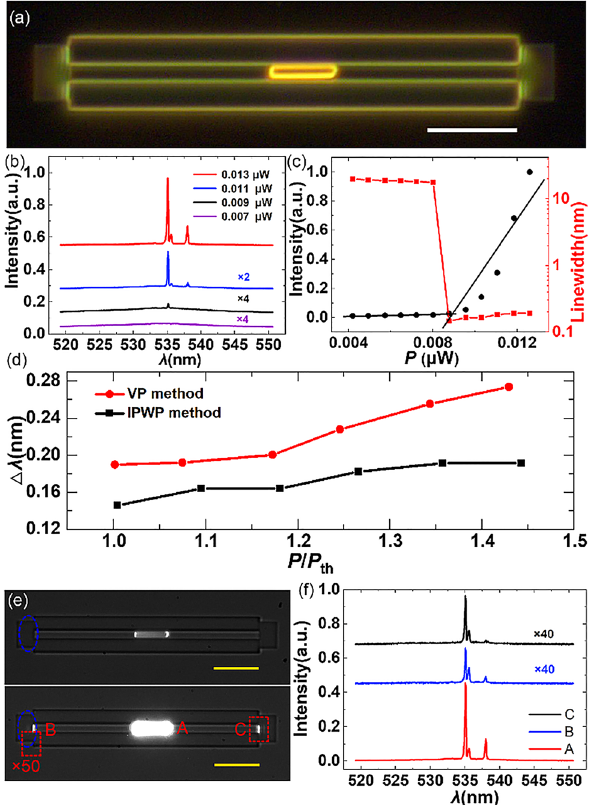
Figure 3: Lasing actions of a perovskite microplate pumped by the IPWP